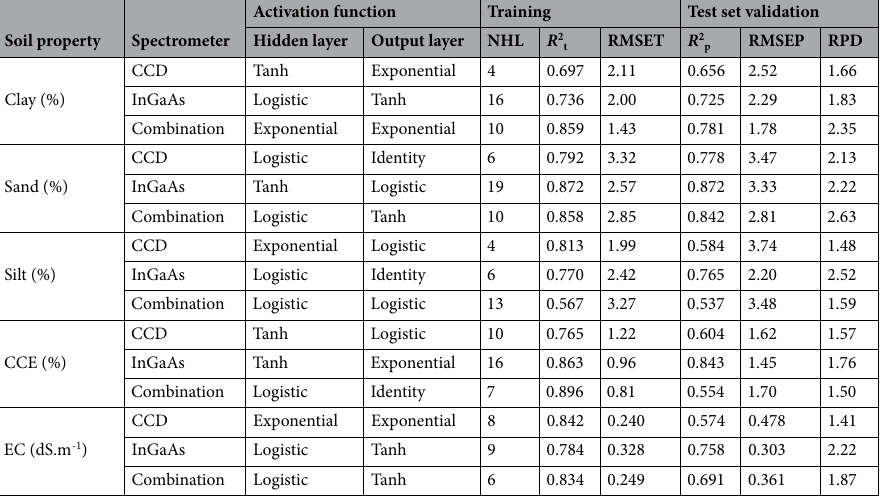
Table 4. ANN calibration and estimation results of selected soil physicochemical properties using spectral data of CCD and InGaAs spectrometers, and the combination data of both. CCD charge-coupled device, CCE calcium carbonate equivalent, EC electrical conductivity, InGaAs indium gallium arsenide, NHL number of nodes in hidden layer, R 2 p coefficient of determination in prediction, R 2 t coefficient of determination